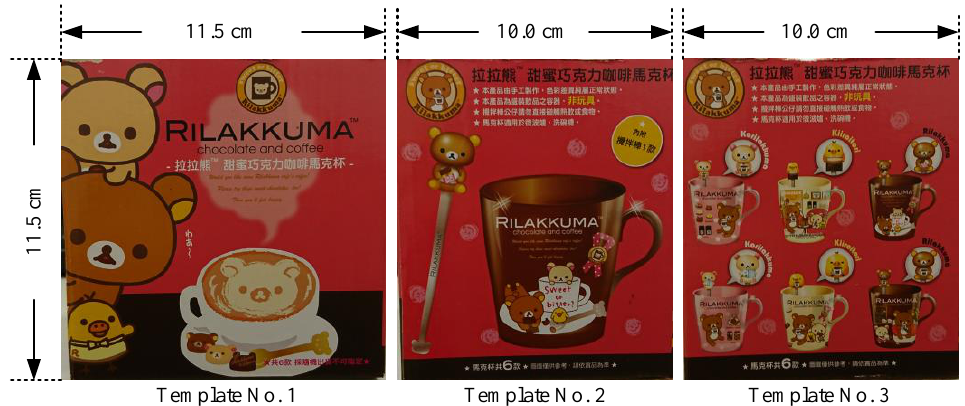
Figure 2. Three template patches of the Object-Of-Interest (OOI) used in the experiments.